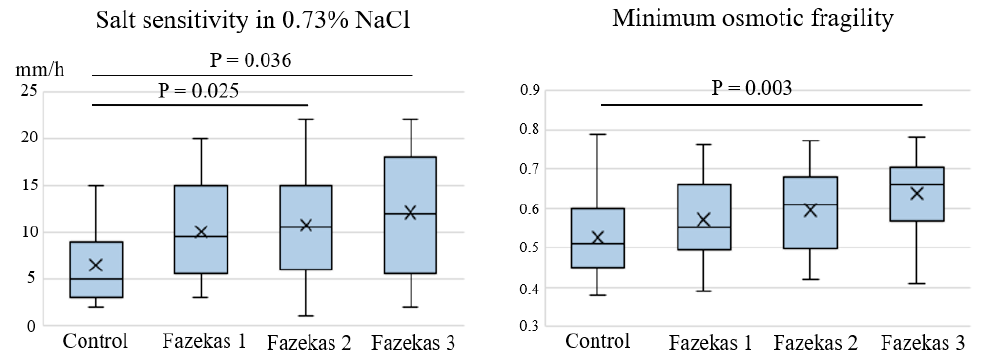
Figure 3. Association between salt sensitivity, osmotic fragility and the severity of WMHs depending on the Fazekas grade.